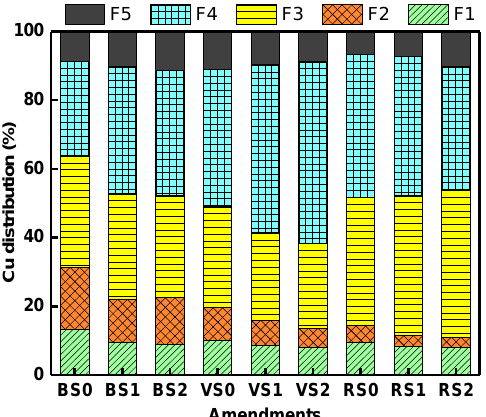
Figure 6. Cu fractionations of soils after 1a incubation with di ff erent BC amendments. F1, exchangeable; F2, carbonate bound; F3, Fe-Mn oxide bound; F4, organic matter bound; F5, residual fraction.